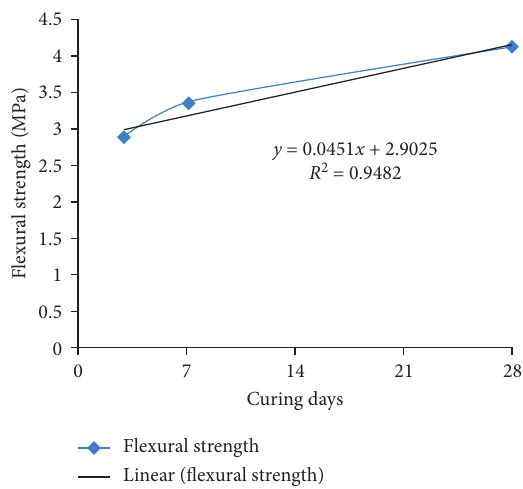
Figure 5: Temporal variations in flexural strength of the con- ventional concrete